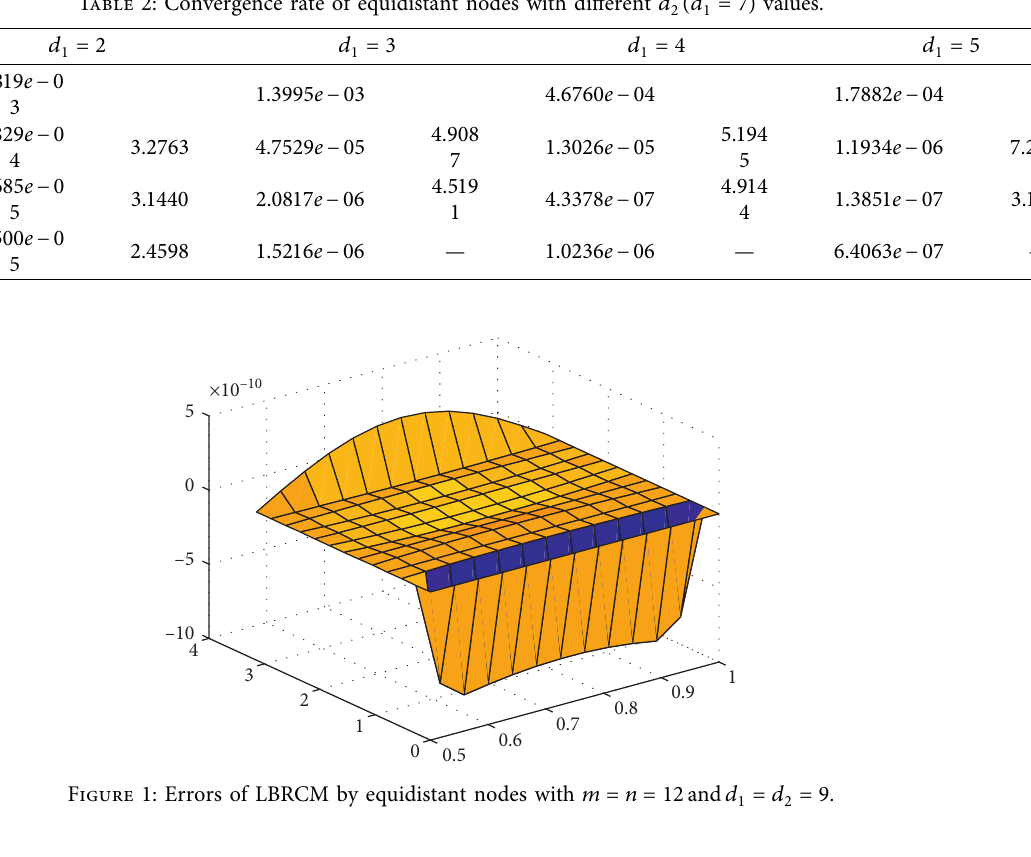
Table 2: Convergence rate of equidistant nodes with different d